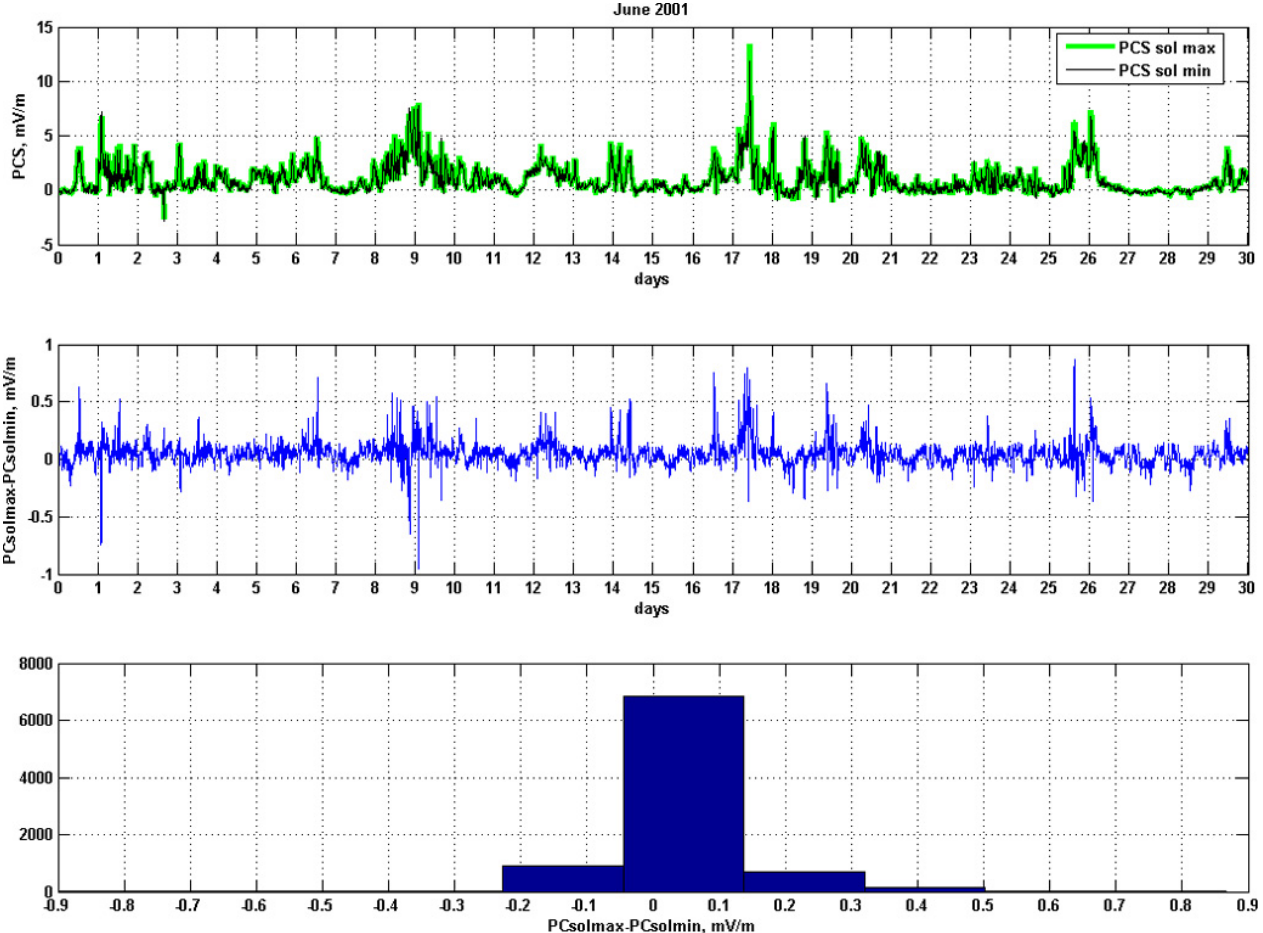
Fig. 7. Indices PC solmax (thick line) and PC solmin (thin line) calculated for Vostok in June 2001. level, remaining in average in range ∼ 10 % of the PC